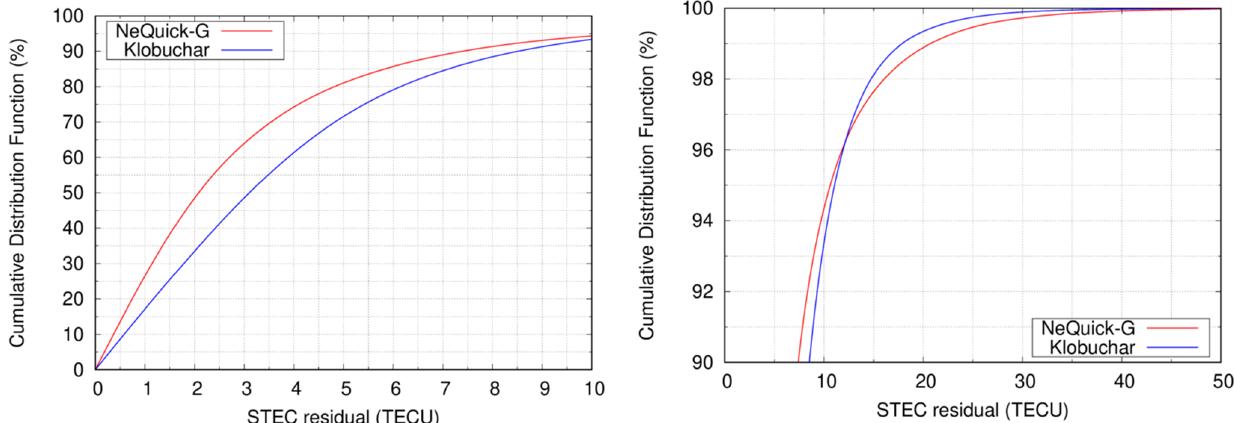
Figure 5. CDF of the STEC errors of NeQuick-G (red) and Klobuchar (blue) ICAs, compared to reference STECs obtained with IAR carrier-phase measurements. The left panel depicts the CDF of the STEC residuals up to 10 TECUs. The right panel depicts the CDF of the STEC errors when the CDF values ranges from 90 to 100%. Table 3. Results of the consistency test between unambiguous and unbiased reference ionospheric values and the prediction computed by Galileo and GPS ICAs.